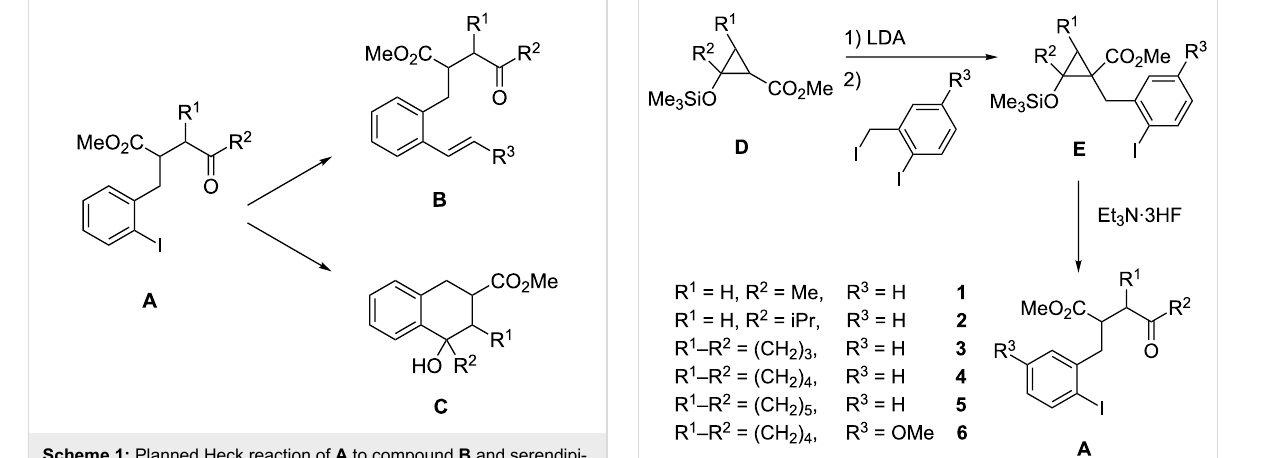
Scheme 1: Planned Heck reaction of A to compound B and serendipi- tous discovery of the palladium-catalyzed cyclization to products C